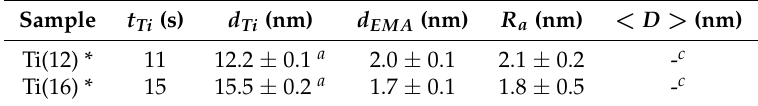
Table 2. The time of deposition ( t Ti ), the thickness of titanium film ( d Ti ) and the EMA layer ( d EMA ), the roughness parameter ( R a ) and the average size of nanocrystallites ( < D > ).